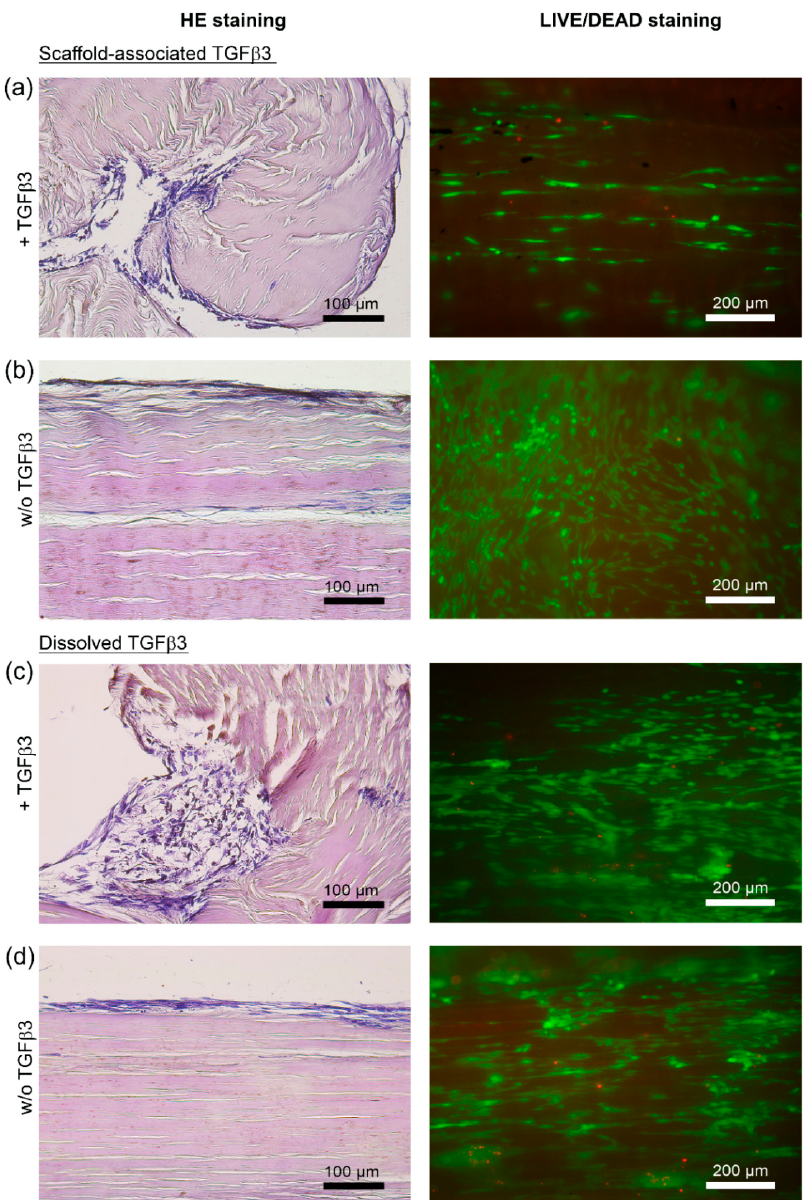
Figure 2. Microscopic appearance of MSC-seeded tendon sca ff olds treated with TGF β 3 ( + TGF β 3) and the respective internal control sca ff olds (w / o TGF β 3). Representative images of hematoxylin- and eosin-stained para ffi n sections of MSC-seeded tendon sca ff olds ( a – d , left) and of corresponding LIVE / DEAD ® -stained MSC-seeded tendon sca ff olds ( a – d , right). The panel of LIVE / DEAD ® -stained sca ff olds shows vital cells in green and cells with defect cellular membranes in red. MSC-seeded tendon sca ff olds were either directly loaded with TGF β 3 (sca ff old-associated) ( a ), or TGF β 3 was applied as a standard cell culture medium supplement (dissolved) ( c ). Respective internal control sca ff olds—( b ) internal control for sca ff olds directly loaded with TGF β 3; ( d ) internal control for sca ff olds that received TGF β 3 as a standard cell culture medium supplement—were not treated with TGF β 3 (w / o TGF β 3). Note the obvious alterations of the sca ff old morphology (left panel of hematoxylin- and eosin-stained sections), illustrating the increased cell-mediated sca ff old contractions in the presence of TGF β 3 regardless of the route of application (( a ) directly applied TGF β 3 and ( c ) TGF β 3 applied as a cell culture medium supplement). All images shown were taken after 5 days from tendon sca ff olds that were seeded with MSC from the same donor